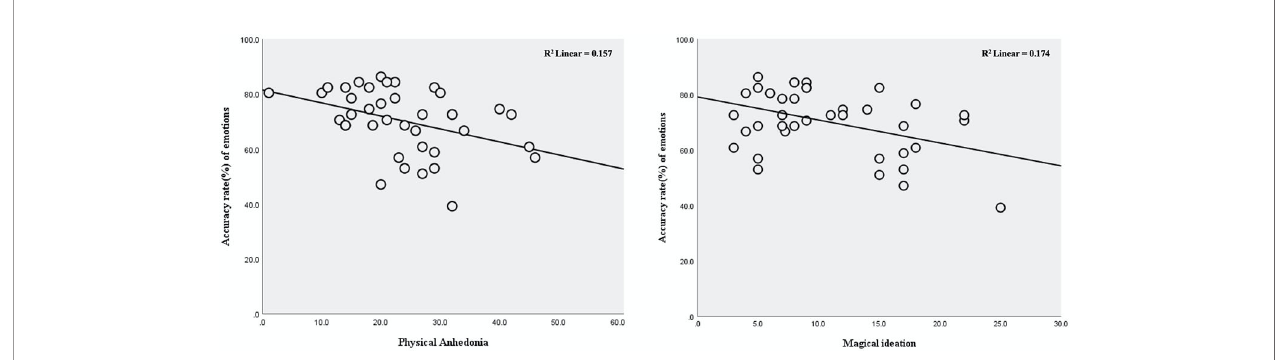
FIGURE 1 | Relationships between accuracy rate for facial emotion recognition and schizotypy scores in individuals at ultra-high risk for psychosis.